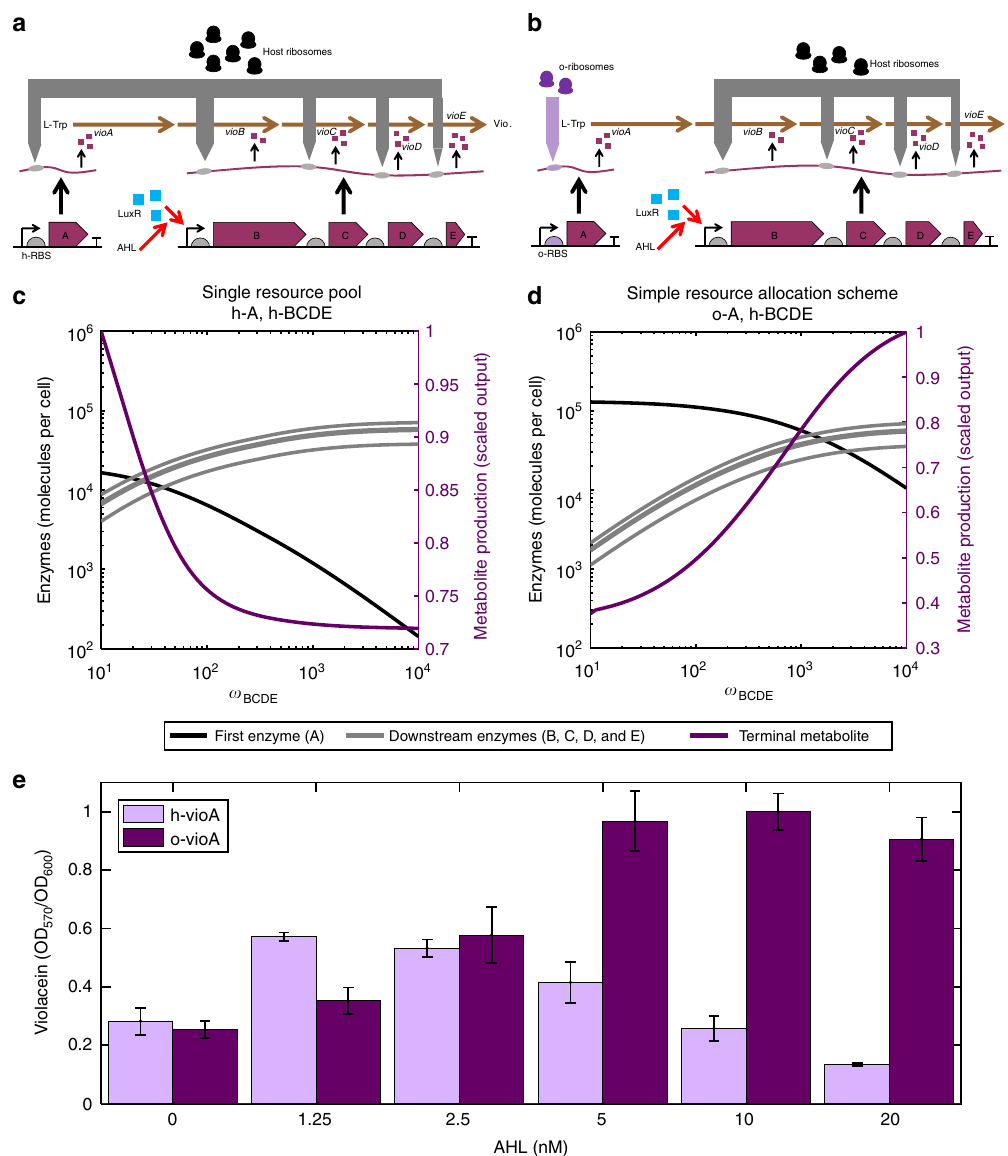
Fig. 4 Resource allocation control increases production of violacein. Violacein is produce from L -tryptophan by a fi ve-enzyme pathway. Experimentally the pathway is divided into two cassettes. vioA is constitutive expressed. The vioBCDE cassette is inducible under the control of AHL. Ribosomes are directed between the cassettes by use of ribosome binding sites as described previously. Simulations show the steady-state concentrations of the pathway enzymes and fi nal metabolite. Note that the enzymes are divided by induction mechanism so that the downstream enzymes are depicted in the same colour. Variation in their levels is determined by protein size only. Scaled metabolite production represents the steady-state amount of the fi nal metabolite in the pathway, scaled by the highest amount achieved across the induction. ω A = 25 molecules per min. ω ρ = 500 molecules per min. The downstream cassette is induced as shown by varying ω BCDE . These enzymes are translated by the host ribosome pool throughout. Other parameters are detailed in Supplementary Note 9. a Single resource pool. Use of host ribosomes by all genes. b Simple resource allocation scheme. vioA translation by the orthogonal ribosome system. c Simulation of the cassettes sharing a single pool of resources. Enzyme A is expressed utilising the host system. d Simple resource allocation scheme by allocating enzyme A to the orthogonal ribosome pool. e Violacein production in vivo per cell at 24 h post induction. Normalised by the largest production per cell achieved across all conditions. Bars represent means ± 1 SD. N = 3